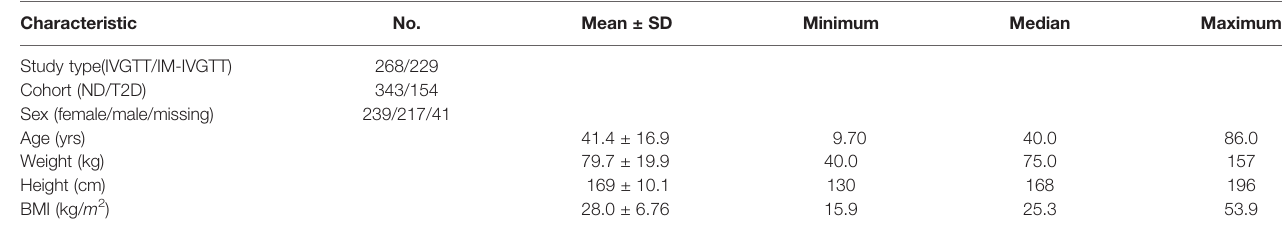
TABLE 2 | Characteristics of study subjects.